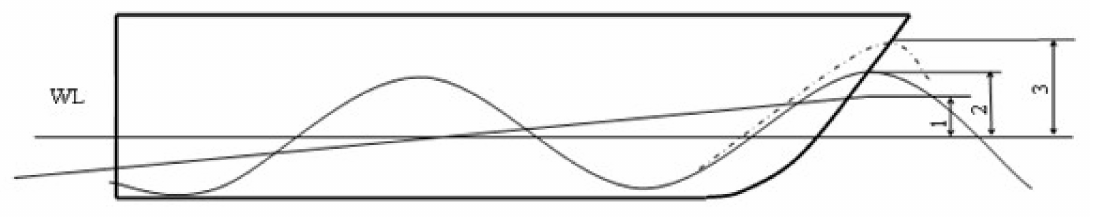
Figure 1. Three parts of the submersion of the bow: 1—pitch; 2—sea waves; 3—formed waves. For small passenger vessels, on a wave of up to 4 points, the amplitude of the pitching can reach 7 ◦ , and the minimum value is 3 ◦ [9]. Bureau Veritas offers values for the amplitude of pitching A r ≤ 0.2 radian. For the selected yachts, it was assumed that the amplitude ϕ was about 3 ◦ , taking into account that the ship has good maritime qualities. Trim t is calculated from the expression t = L × tg ϕ . Immersion of the bow, as a result of pitching will be equal to half the trim.